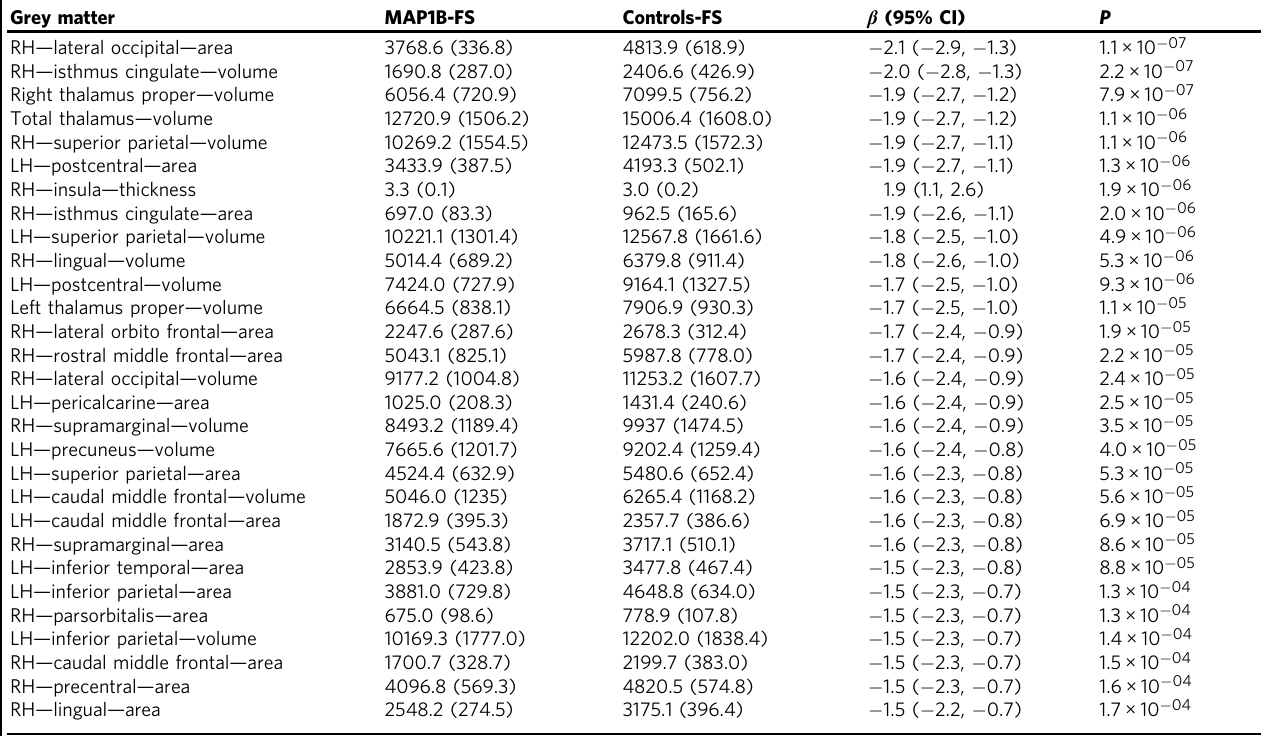
Table 4 Brain grey matter differences in MAP1B LoF carriers compared with controls